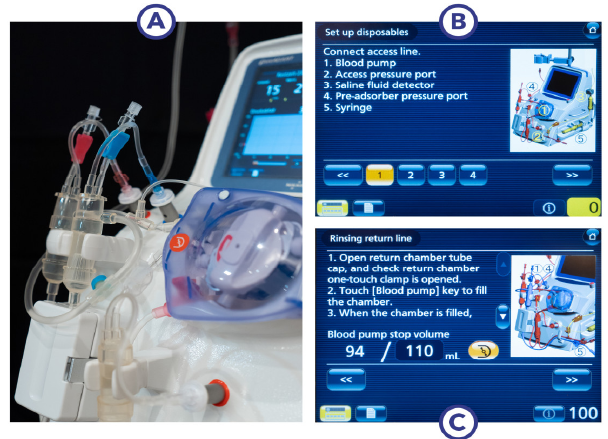
Figure 2. Graphical user interface with touch screen. ( A ) Nikkiso apheresis machine during setup; ( B ) touch screen: setup of the tubing; ( C ) rinsing instructions.